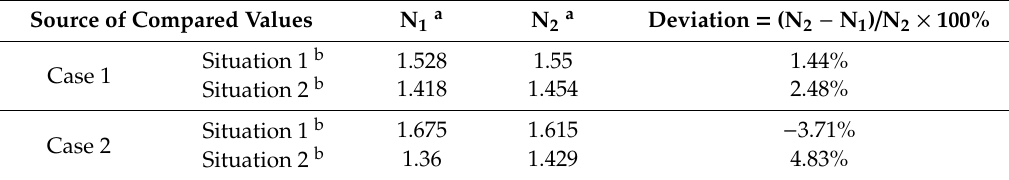
Table 2. Comparison between the simulated and measured